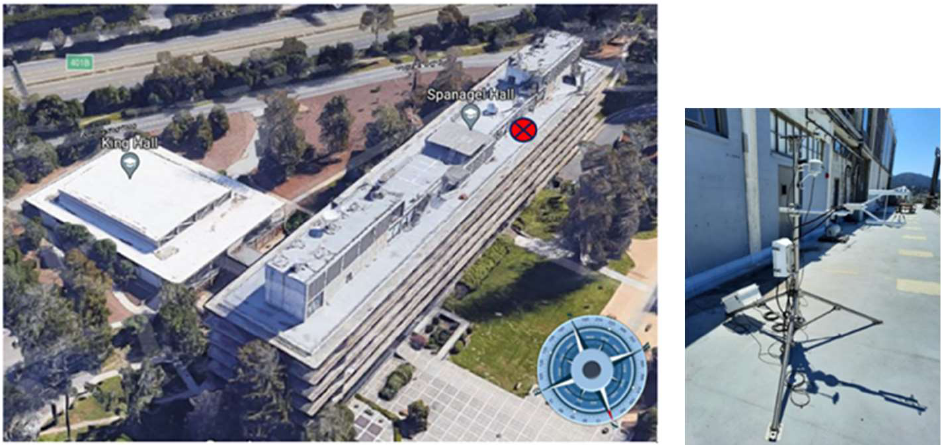
Figure 1. The experimental setup location on the roof of Spanagel Hall ( left ) and the instruments utilized to obtain the macroscopic meteorological parameters ( right ).